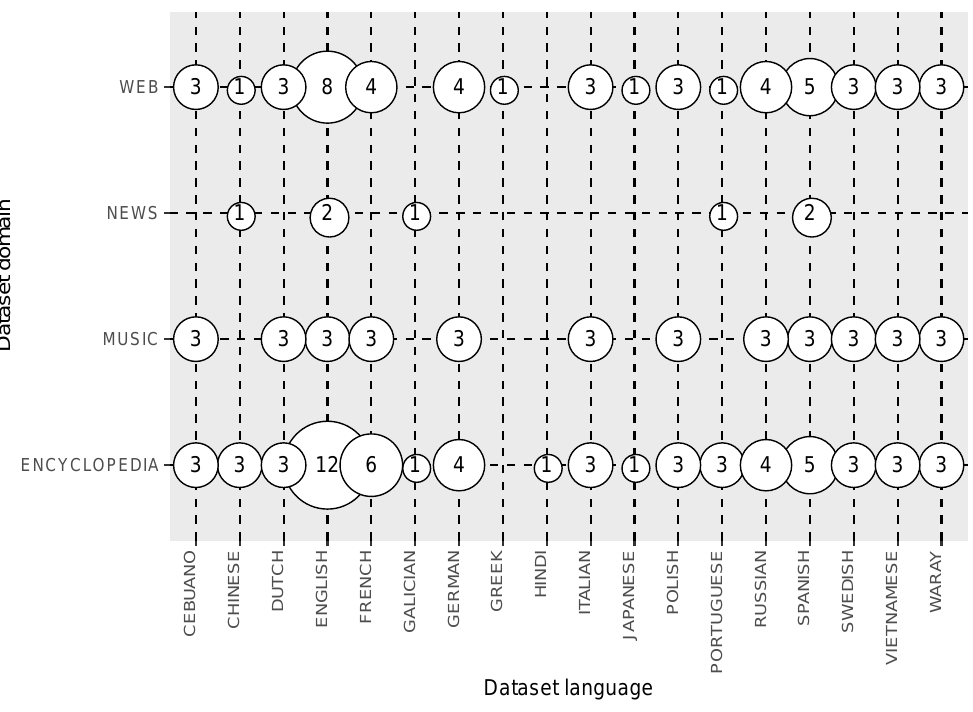
Figure 9. Dataset language per domain. (Authors’ own).